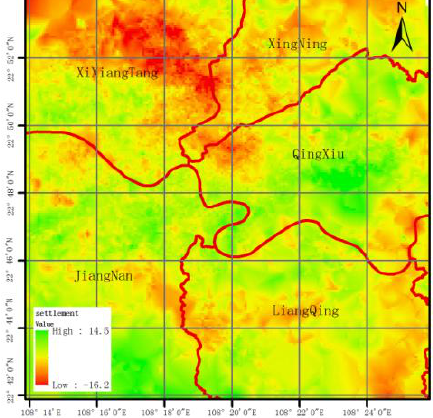
Figure 4. Nanning urban settlement